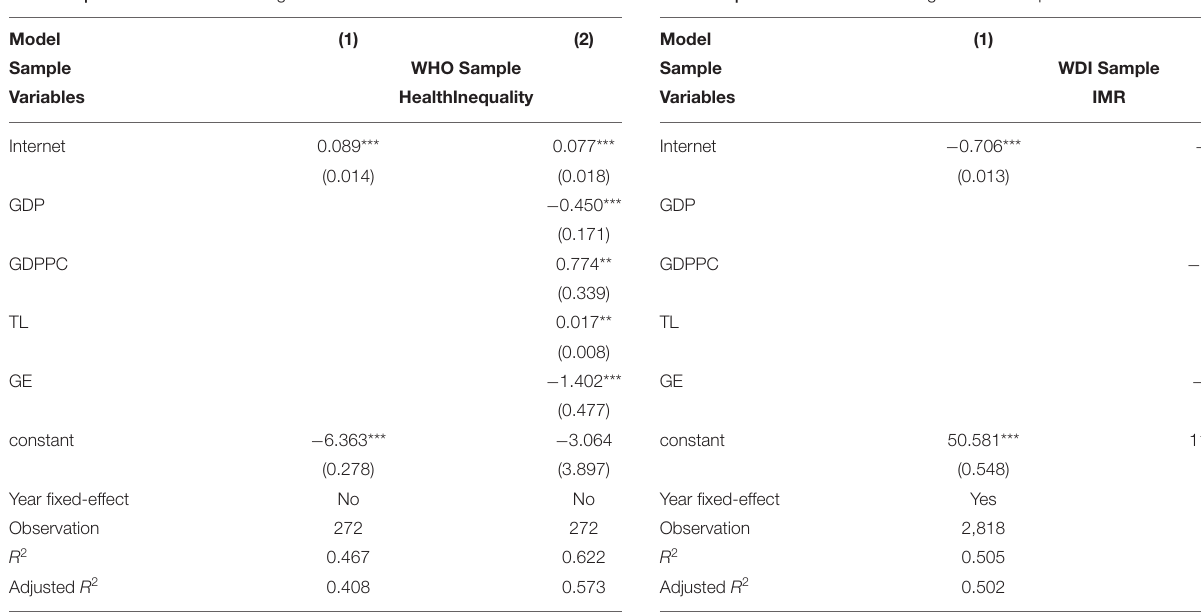
TABLE 7 | Robustness checks using alternative estimations. TABLE 8 | Robustness checks using different